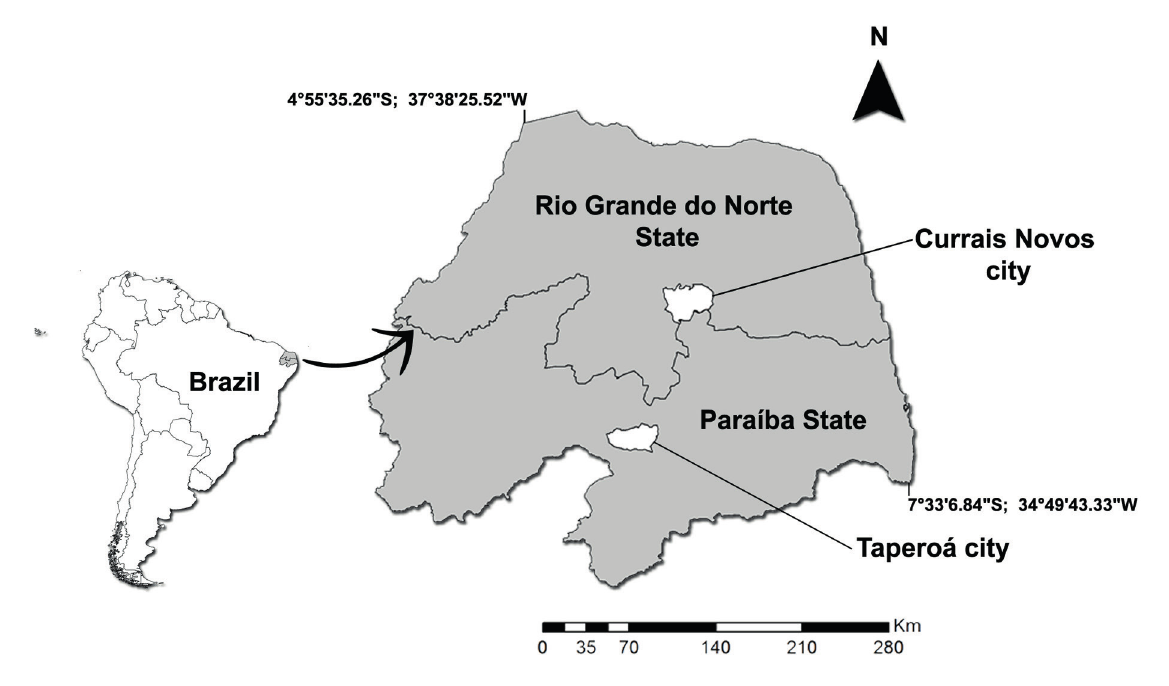
Figure 1 - Location map of the fossil localities (Lagoa do Santo site, Currais Novos municipality, rio Grande do Norte State and Campo Alegre site, taperoá municipality, Paraíba State).